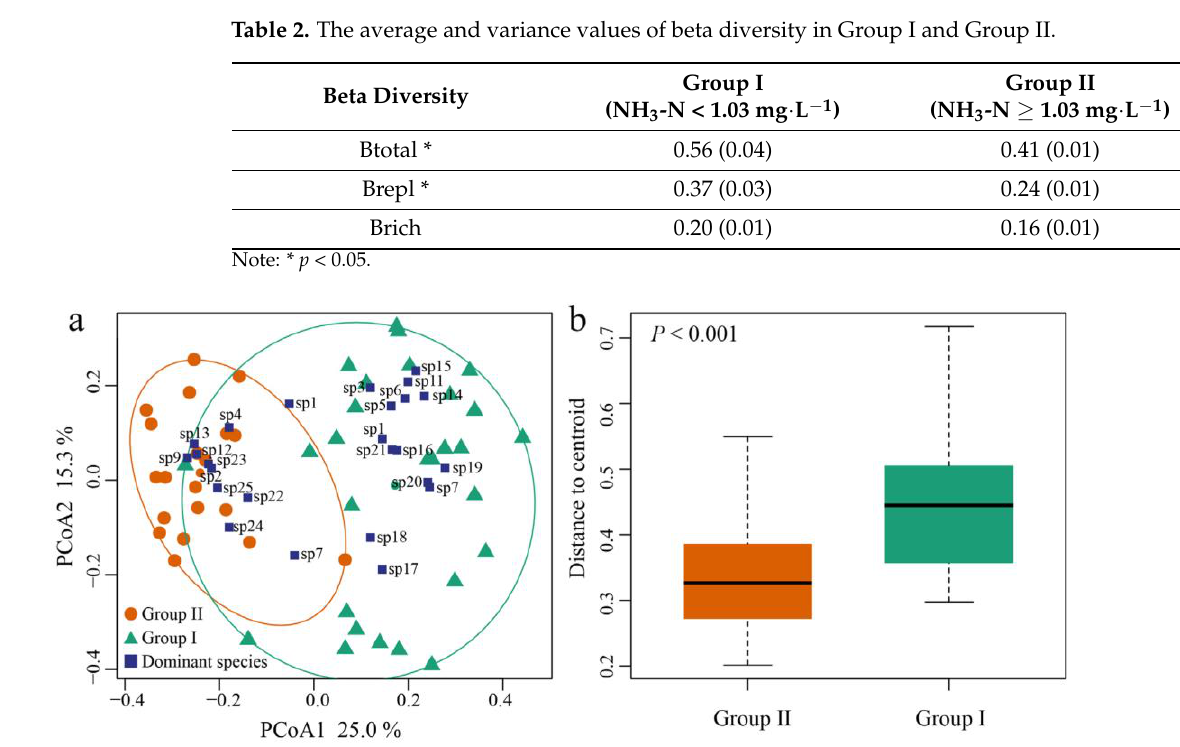
Figure 4. PcoA showed the differences in zooplankton community structure ( a ) and average dis- tance to centroid ( b ) between Group I (NH 3 -N < 1.03 mg·L −1 ) and Group II (NH 3 -N ≥ 1.03 mg·L −1 ). sp1, Polyarthra dolichoptera ; sp2, P. trigla ; sp3, Brachionus angularis ; sp4, B. calyciflorus ; sp5, B. forficula ;